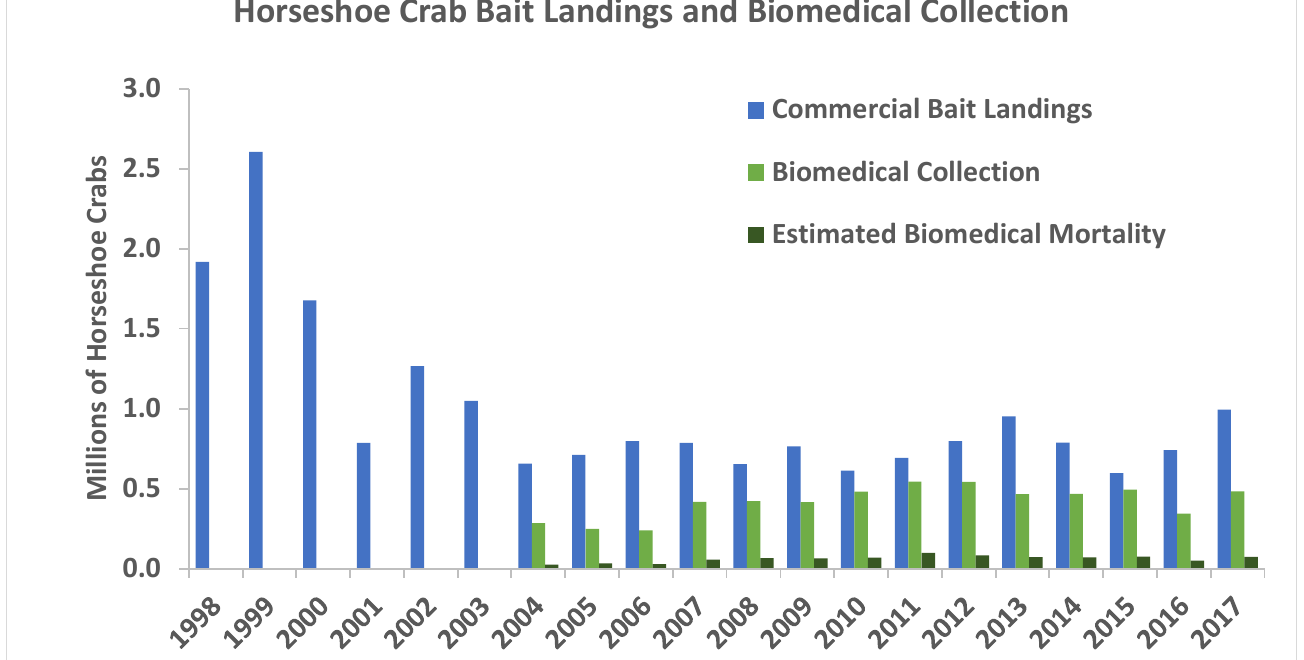
Figure 2. Coastwide horseshoe crab bait landings, biomedical collection, and estimated mortality attributed to the biomedical industry. Biomedical data has been reported to ASMFC since 2004 and a 15% rate is applied to the number of horseshoe crabs bled and released alive to estimate mortality from the industry.